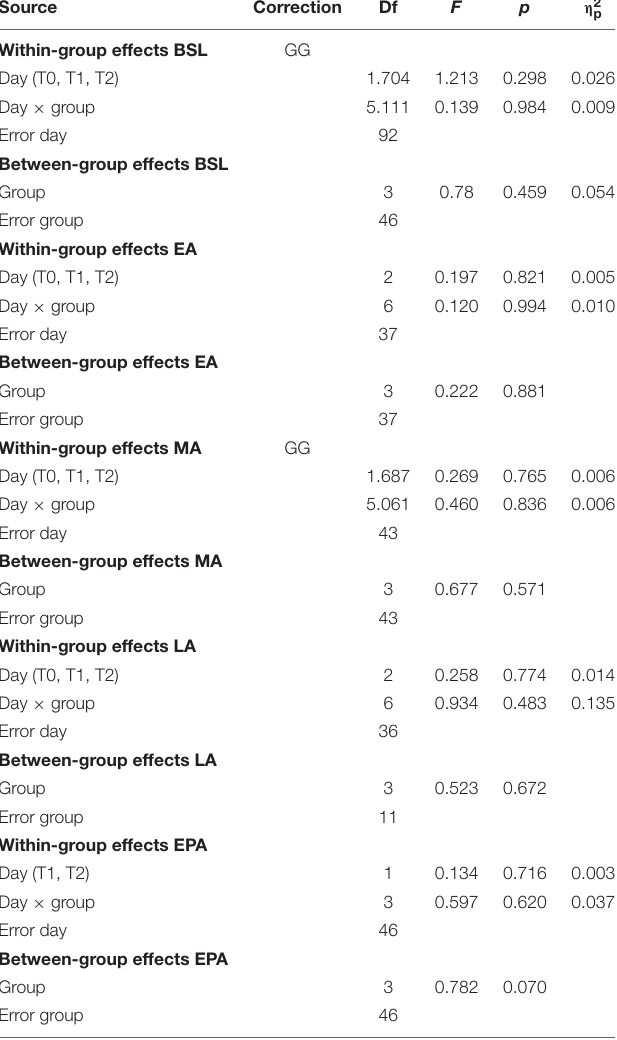
TABLE 4 | Two-way mixed-model ANOVA of gaitline length symmetry across training phases (BSL, late baseline; EA, early adaptation; MA, mid-adaptation; LA, late adaptation; EPA, early postadaptation) Mixed model ANOVA with the between-subject factor group (HC-sham, HC-real, PwMS-sham, PwMS-real) and the within factor day (T0, T1,